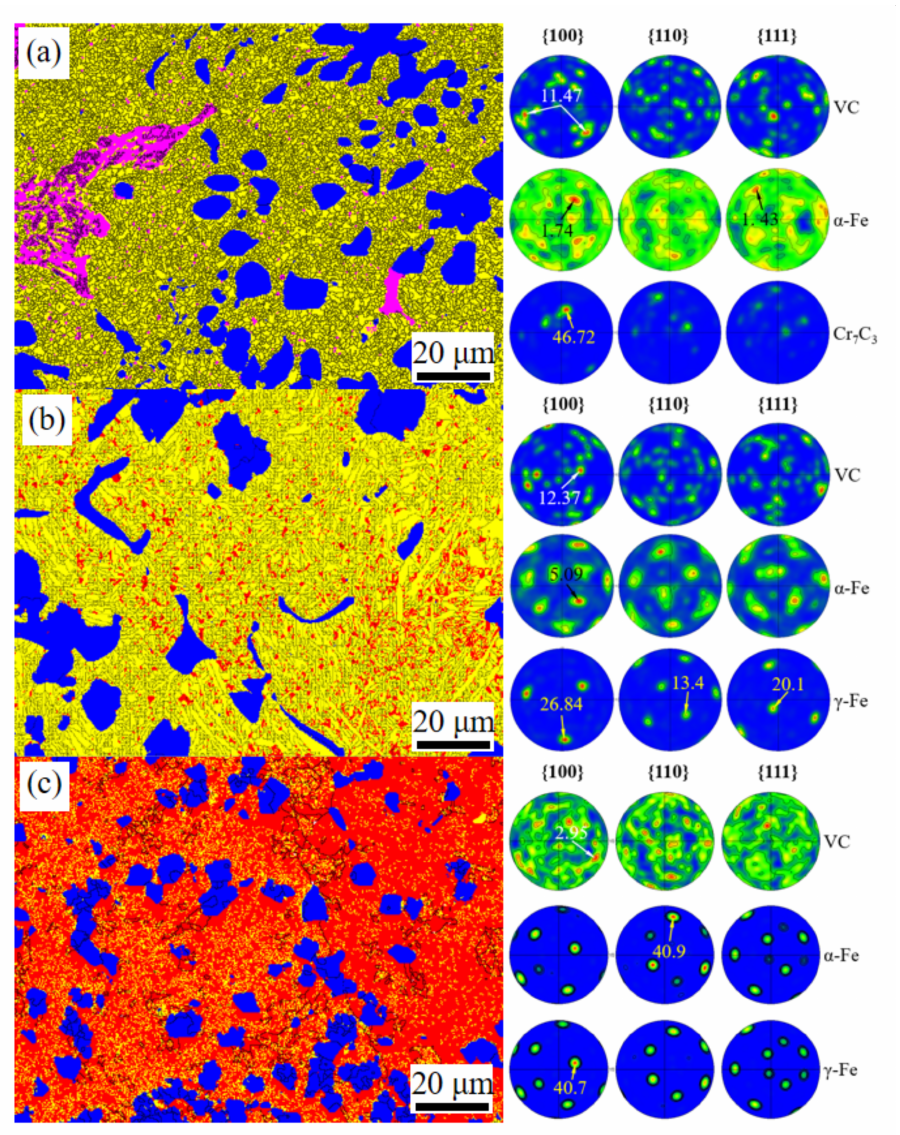
Figure 4. EBSD images and the corresponding pole figures of three samples with ( a ) 1.5 Mn; ( b ) 3.0 Mn; ( c ) 4.5